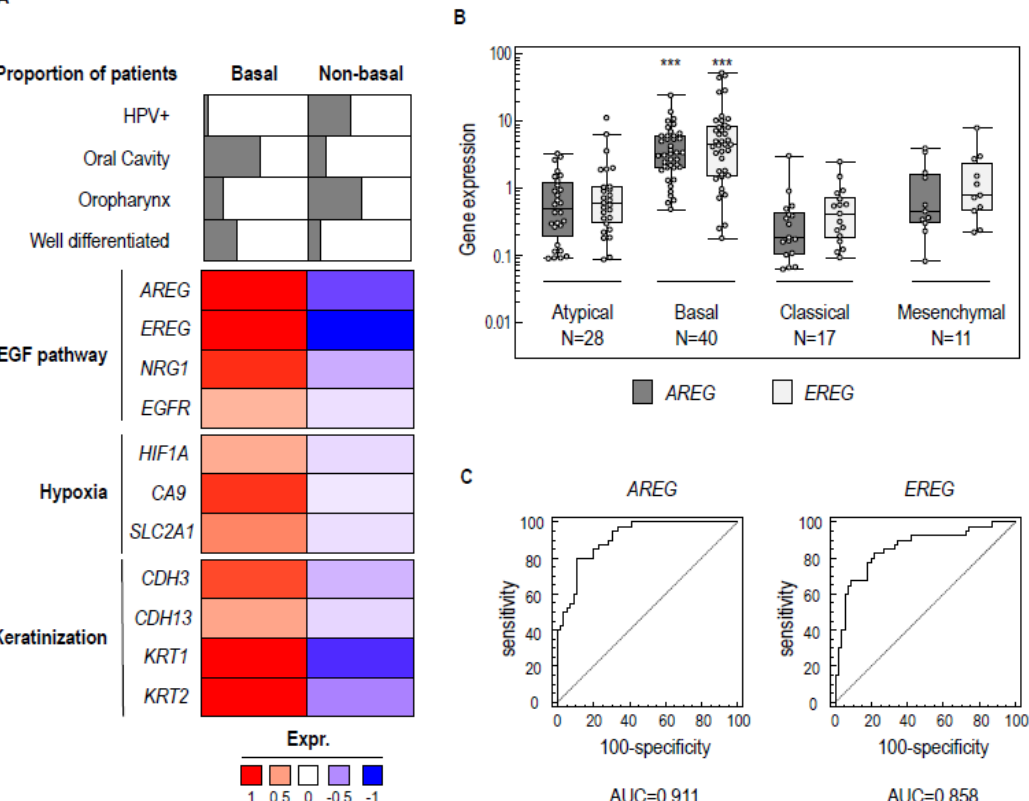
Figure 1. Molecular features of basal head and neck squamous cell carcinoma (HNSCC). ( A ) Summary of the main pathology features and pathway enrichment analysis of the basal HNSCC subgroup in public omic data sets [5–8]. ( B ) Boxplot of the gene expression of AREG and EREG genes measured by RT-qPCR in basal, mesenchymal, atypical, and classical HNSCC. Expression levels were compared between tumor subgroups and were found to be significantly higher in basal HNSCC compared to other molecular subgroups (ANOVA *** p < 0.001). ( C ) Receiver Operating Characteristic (ROC) curve analyses of the ability of AREG and EREG gene expression levels to discriminate between basal and non-basal HNSCC. The area under the curve (AUC), corresponding to the optimal specificity and sensitivity, is